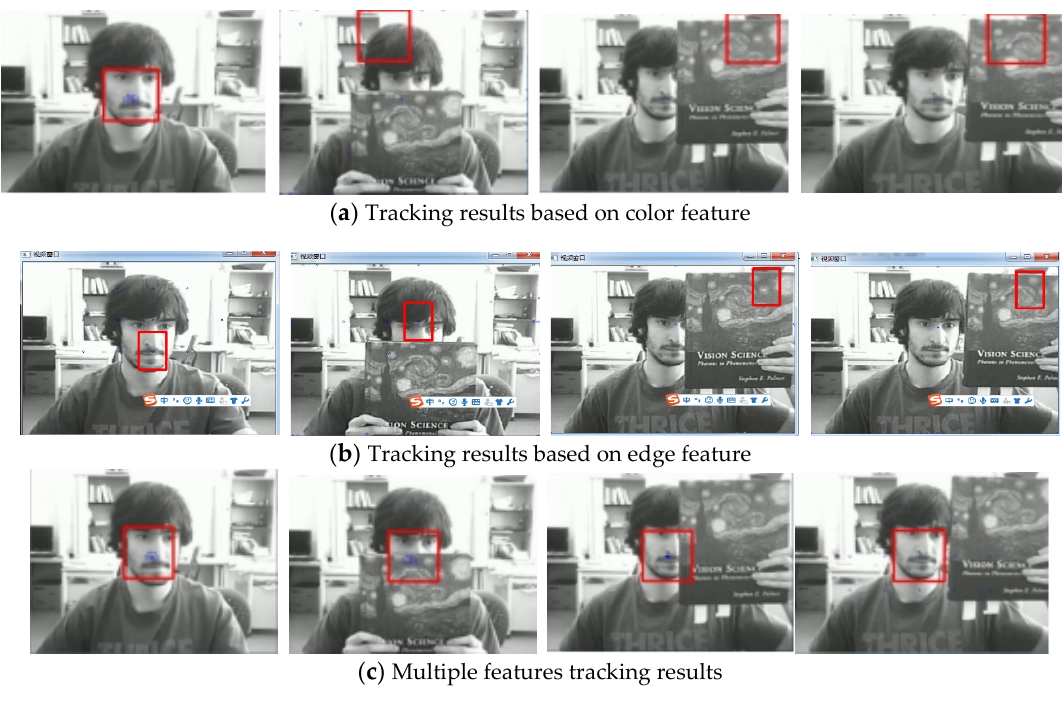
Figure 12. Tracking results under the background changes.